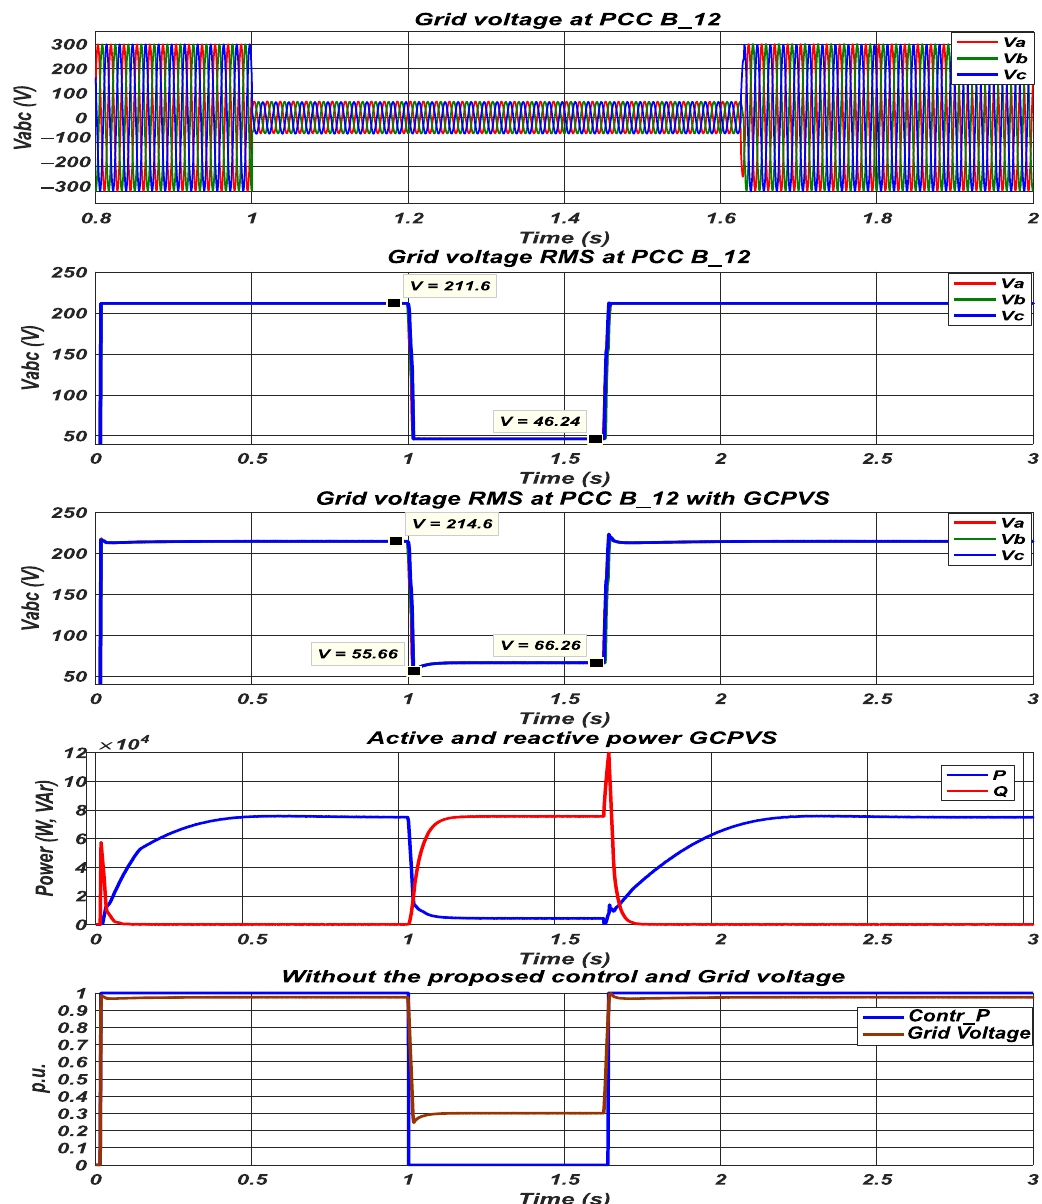
Figure 17. Simulation results of the GCPVS proposed for SDVV/MVD: symmetric three-phase short-circuit for 625 ms, without proposed control action.